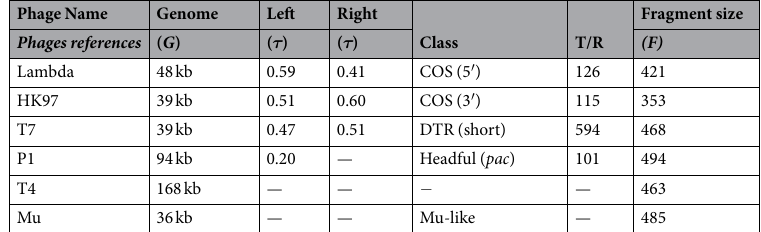
Table 1. Characteristics of reference phages.